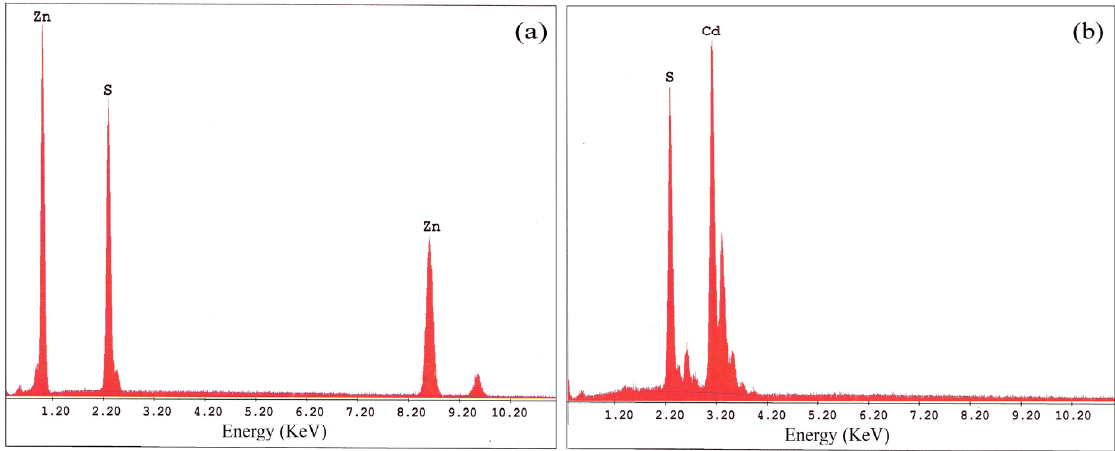
Figure 2. EDX pattern of ( a ) ZnS and ( b ) CdS nanoparticles.